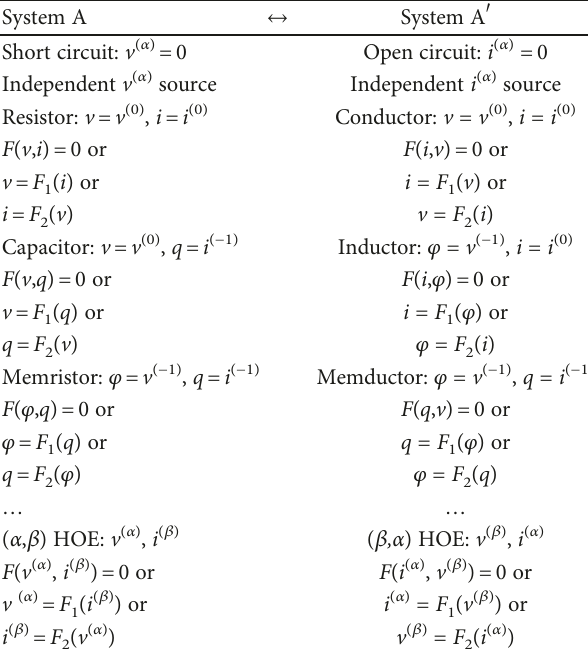
Table 1: Dual terms. The symbols F , F constitutive relations ( F =implicit, F elements, and F =for voltage-controlled elements). 2